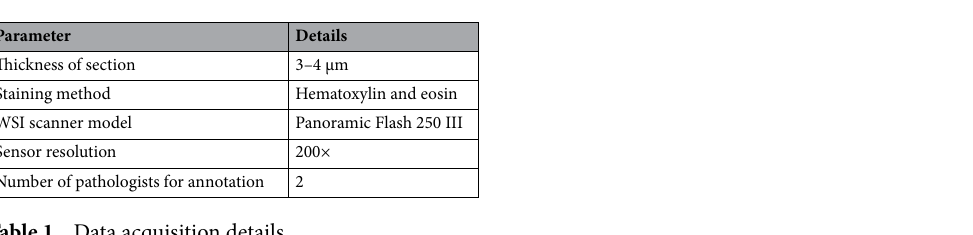
Table 1. Data acquisition